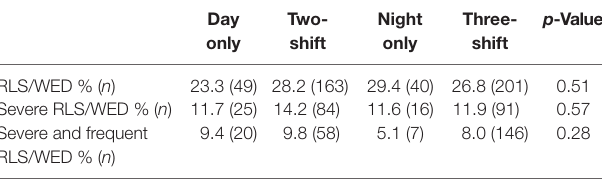
TaBle 2 | Prevalence of RLS/WED among nurses in different types of shift work